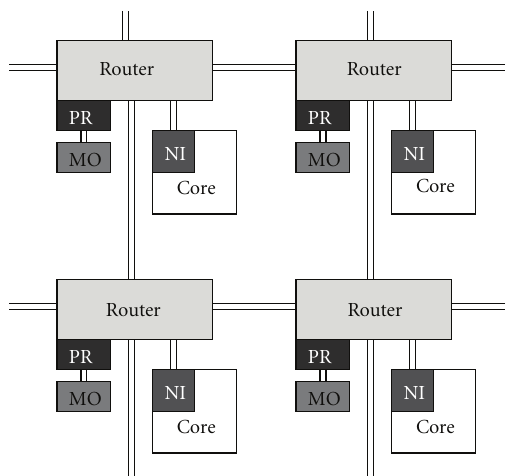
Figure 2: Network topology showing the connections between routers, networks interfaces (NI), monitors (MO), probes (PR), and cores in a part of mesh shaped